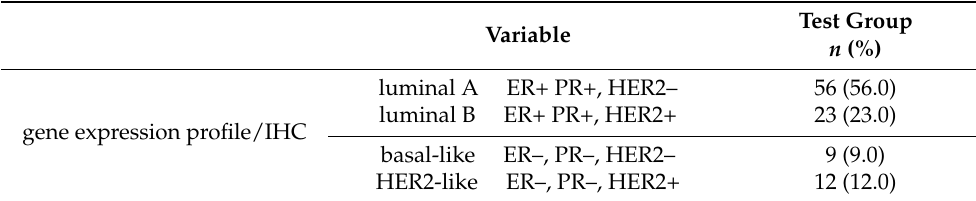
Table 3. Expression of ER, PR, and HER2 receptors in